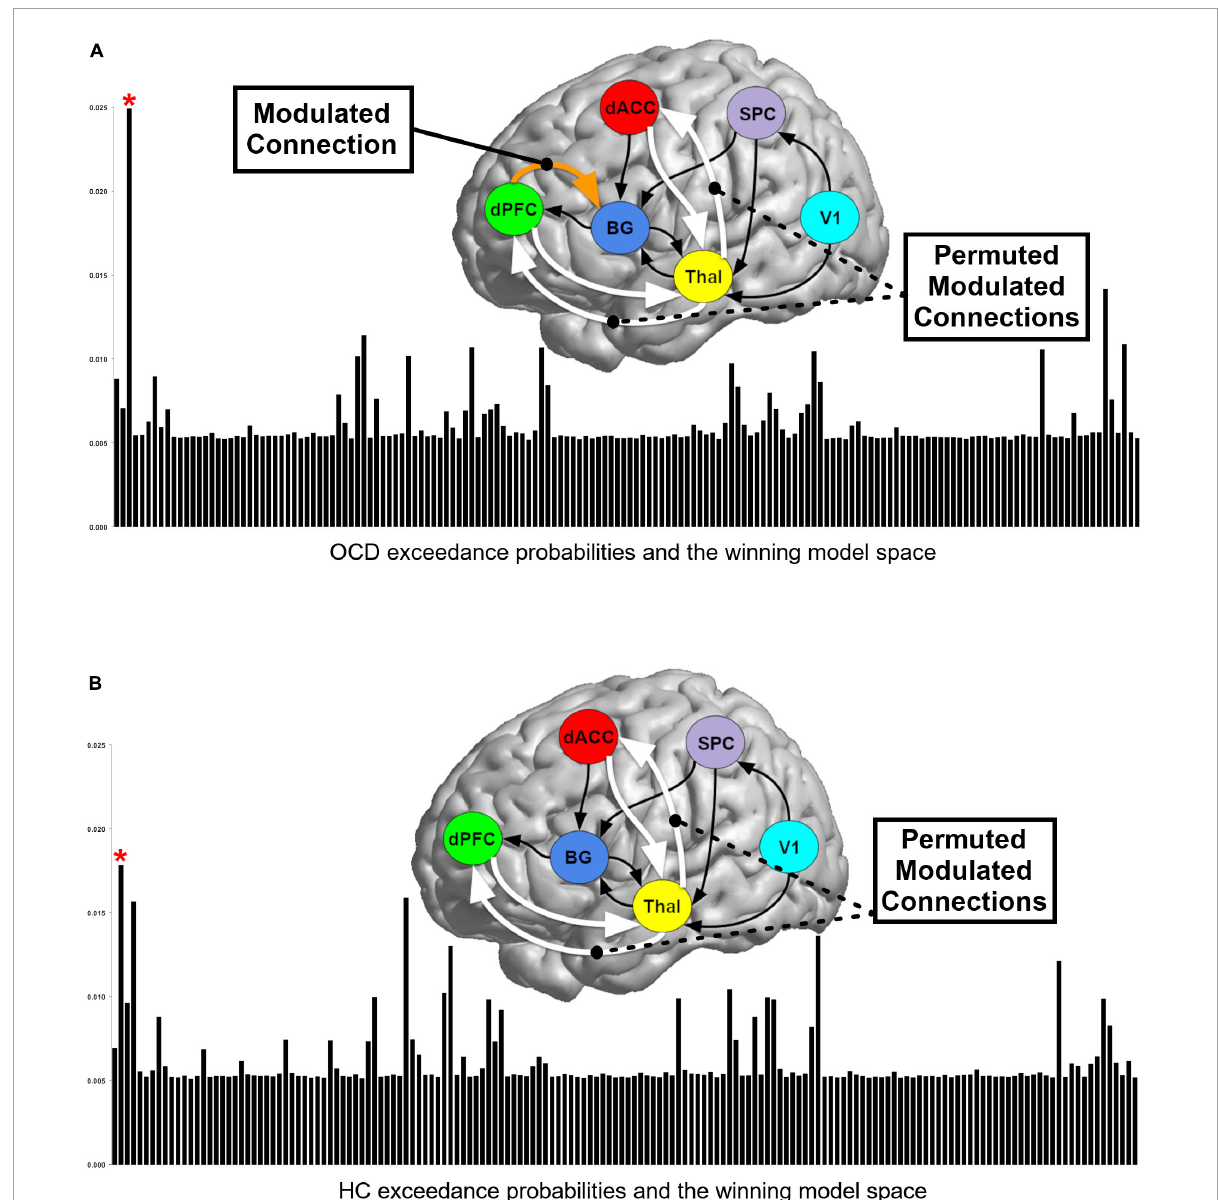
FIGURE3 Bayesian model selection (BMS) results for (A) OCD and (B) HC. Exceedance probabilities (relative likelihood) for each of the 162 models generated are depicted in the skyscraper plots for each of the (A) OCD and (B) HC groups. Red asterisks denote models with the highest exceedance probability. BMS revealed slightly different winning models for OCD and HC groups and these differing model structures are depicted above each plot (see text for